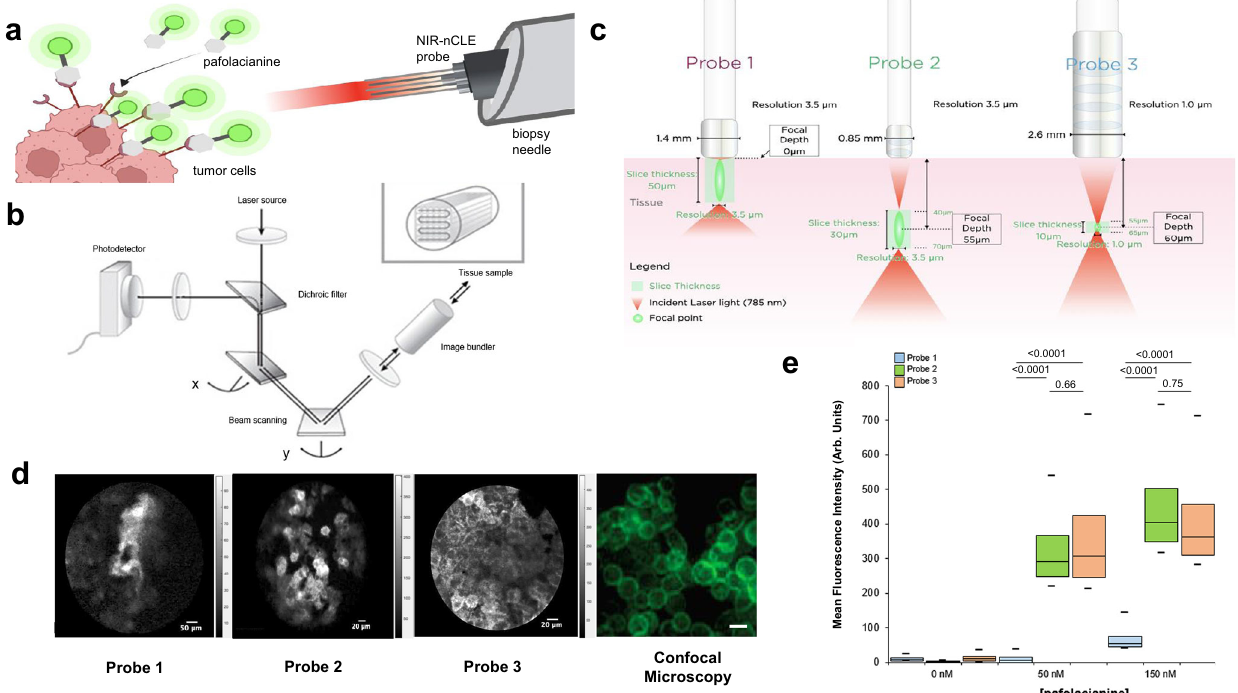
Fig. 1 NIR-nCLE detects pafolacianine-labeled cells in culture. a Schematic overview of the principle behind NIR-nCLE: the detection of individual malignant cells labeled with a targeted NIR tracer within the lumen of a biopsy needle. b Technical overview of the three NIR-nCLE probes tested in the study. c Schematic representation of the technology underlying CLE. A laser beam is directed to the tissue sample via an image bundler. The resulting emission of light is retrieved and fi ltered through a pinhole before reaching the photodetector. x and y represent the two axes of the CLE image. d Representative images taken with the three NIR-nCLE probes of pafolacianine-labeled KB cells in culture and compared to images obtained with conventional confocal microscopy ( n = at least 50 imaging frames from three independent samples). Scale bars represent 20 µ m. e Mean fl uorescence intensity (MFI) of KB cells stained with increasing concentrations of pafolacianine and imaged with the three NIR-nCLE probes. Minima, center, and maxima of boxes represent 25th percentile, mean, and 75th percentile of MFI obtained for the entire imaging sequence. (at 0 nM pafolacianine, n = 88, 100, and 96 frames for Probes 1, 2, and 3, respectively; at 50 nM pafolacianine, n = 88, 188, and 123 frames for Probes 1, 2, and 3, respectively; at 150 nM pafolacianine, n = 71, 350, and 66 frames for Probes 1, 2, and 3, respectively). Whiskers represent the 5th and 95th percentile of MFI over the same sequence. Statistical comparisons were performed using two-sided t tests and p values are shown on the